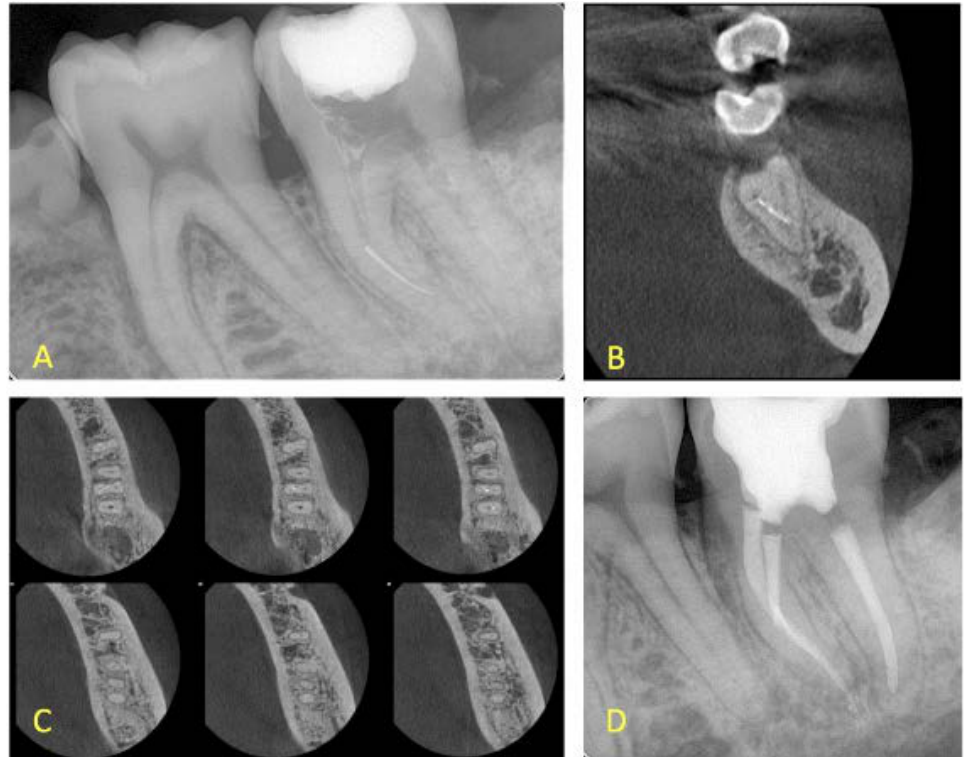
Figure 5. ( A ) Initial periapical radiograph of a mandibular second molar with an instrument fracture at the middle-apical third of the mesial root, ( B , C ) Coronal and axial views demonstrating that the fragment is located at the mesiolingual canal and the two canals are merging at the apical third, ( D ) Final radiograph in which the fragment has been removed with no excess dentin removal. The present study was performed using an observational paired design, which gives the advantage of comparing the same elements acquired by different radiographic assess- ments or evaluators in two different time periods. Nevertheless, the study was not free of limitations. No a priori sample calculation was performed, as this is the first study in the field; however, all of the patients who proceeded for treatment due to intracanal presence of fragments over a one-year period were included, revealing a considerably representa- tive sample. In addition, the identified significant effects together with the uncertainty bounds recorded demonstrate that the study sample may be considered adequately pow- ered to reveal these effects. In any case, presentation of the confidence intervals for the identified effect sizes allows for an estimation of the precision with regard to the treatment effect, indicating the grounds where the true effect is likely to appear in other similar stud- ies [31,32]. Moreover, no blinding of the clinicians took place; however, this could not have been possible given the design of the study, and the fact that the clinicians already had prior knowledge of the case, from the initial examination with the periapical radiograph. However, statistical analysis was performed by an independent investigator who did not participate in any part of the examination of the patients and was blinded to data record- ings for treatment planning through coding utilization. In conclusion and so far, no clear recommendations and perspectives could be given about the clinical usefulness of CBCT in cases with fractured instruments. Three in vitro studies have been performed investigating a similar matter and supporting that periapical